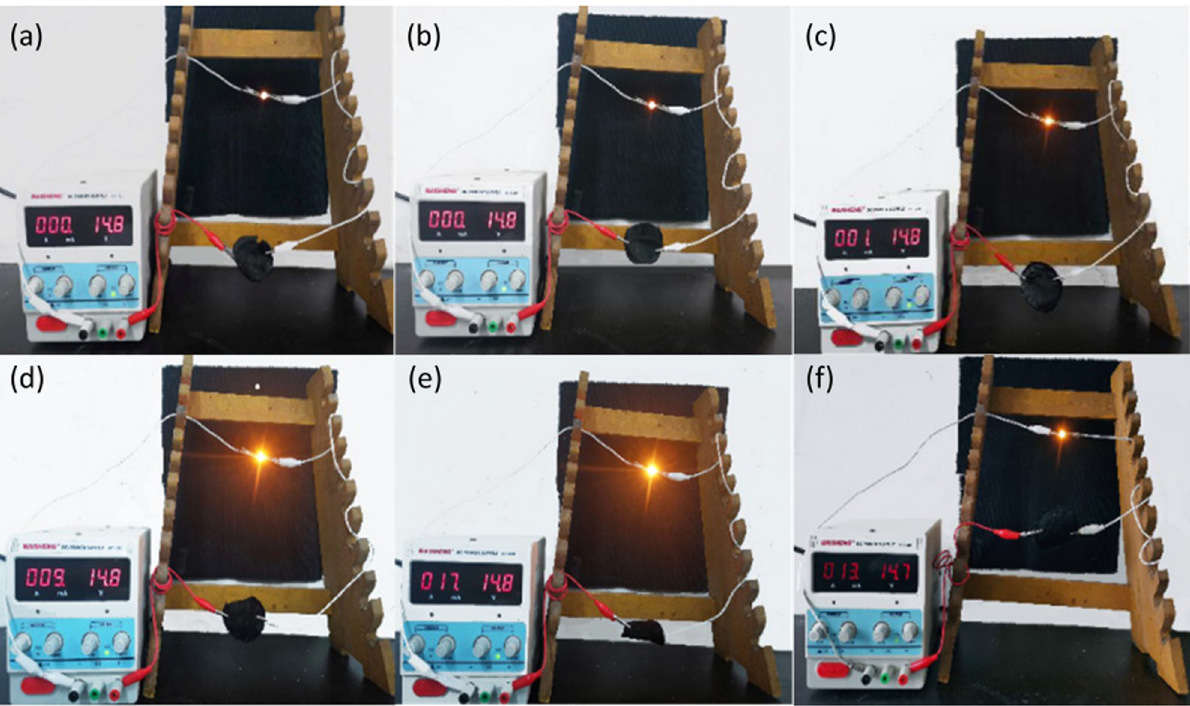
Figure 7: The LED lamp bead brightness picture of SF/PEDOT membrane prepared at di ff erent time: ( a ) 0.5 h, ( b ) 1 h, ( c ) 2 h, ( d ) 4 h, ( e ) 8 h, and ( f ) 16 h.